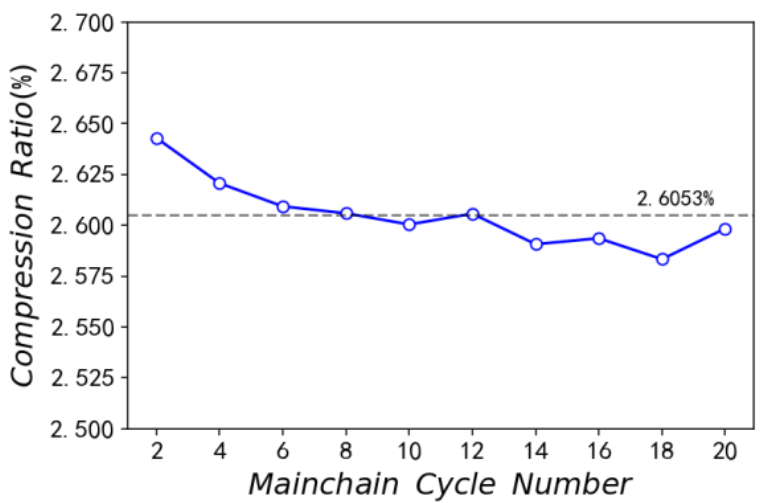
Figure 10. Comparison of the ledger data volume (single world state creation transactions). To realize a more accurate comparison, the ratio of the ledger volume of the business node in the CBCS system to the ledger volume of the fabric node in the comparison system is calculated to obtain the compression ratio, com_ratio = volume_business/volume_fabric . A smaller compression ratio indicates that the business node in the CBCS system occupies less space for ledger storage compared to the fabric node in the comparison system. The compression ratio over 20 mainchain cycles is calculated and shown in Figure 11. When all blockchain transactions are world state creation transactions, the average ledger volume of the business node in our scheme is 2.6053% of that of the fabric node in the comparison system, indicating that our scheme can efficiently reduce the ledger storage space of business nodes.